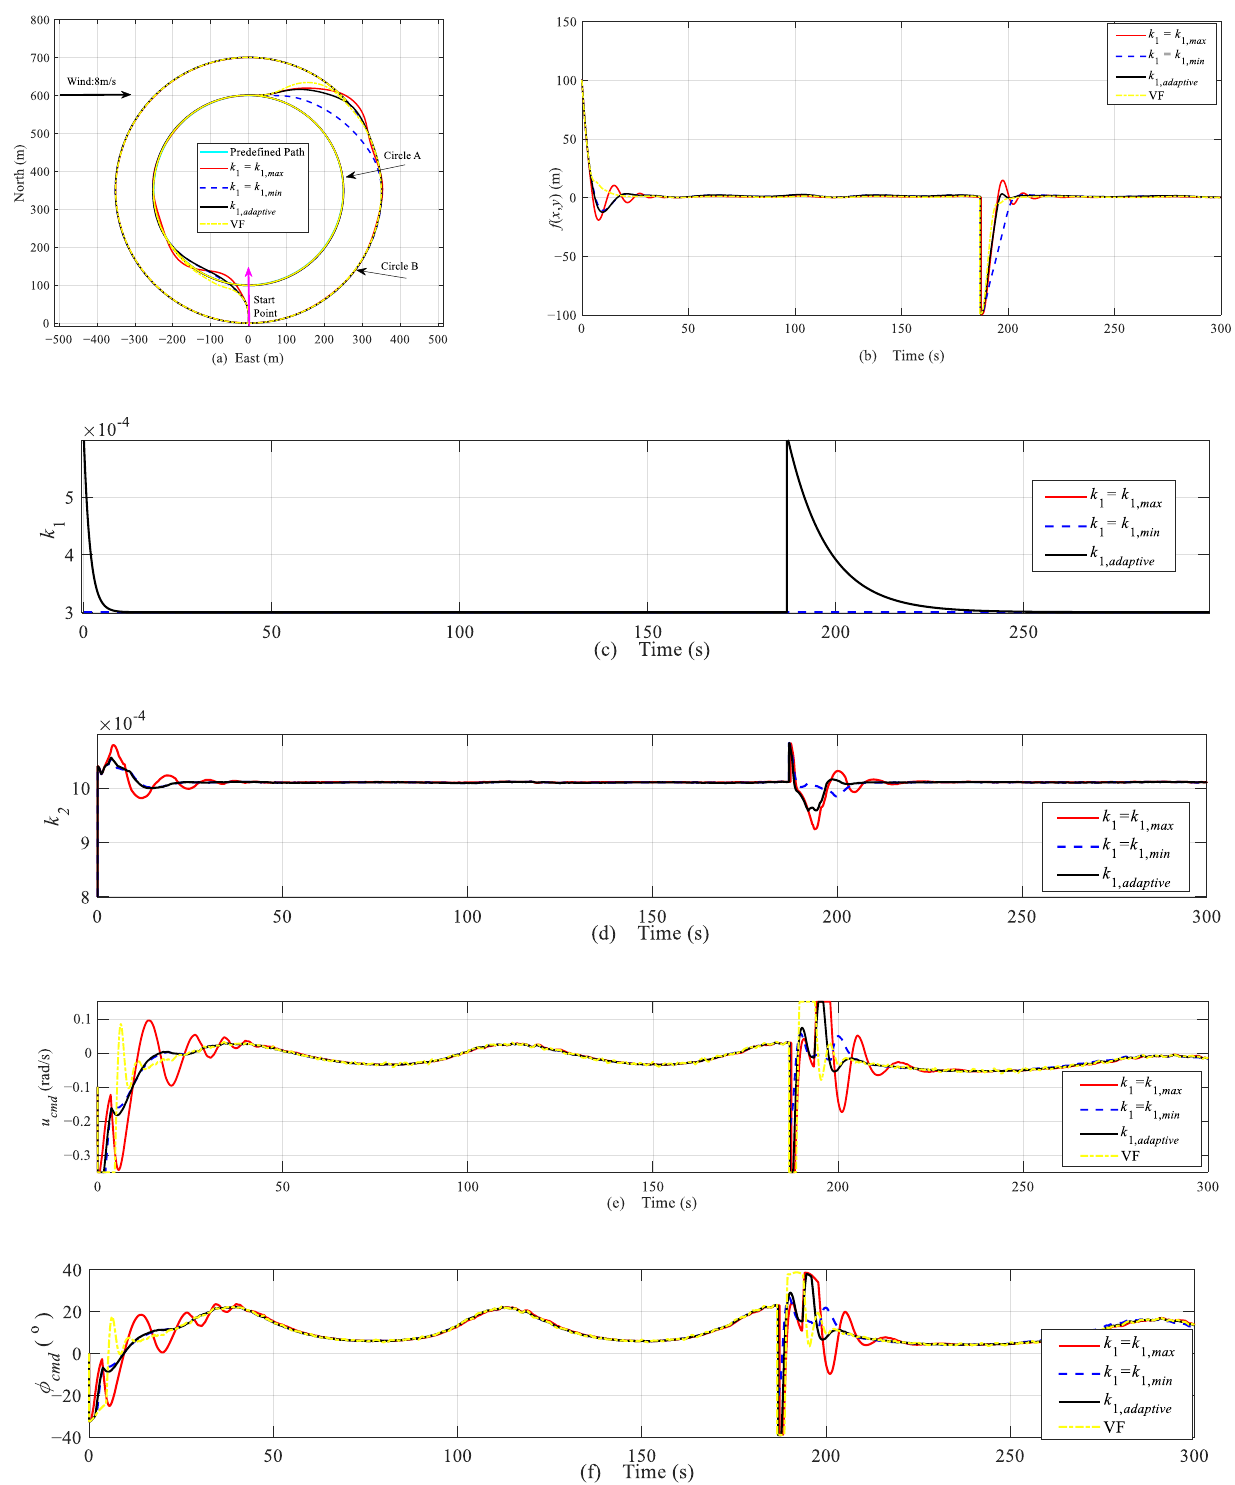
Figure 11. Comparison of the circular path following using the four methods PFC_ k 1, max , PFC_ k 1, min , PFC − k 1, adaptive , and VF. ( a ) The position; ( b ) the distance f ( x , y ) ; ( c ) the parameter k 1 ; ( d ) the param- eter k 2 ; ( e ) the course rate command u cmd ; ( f ) the bank angle command φ cmd